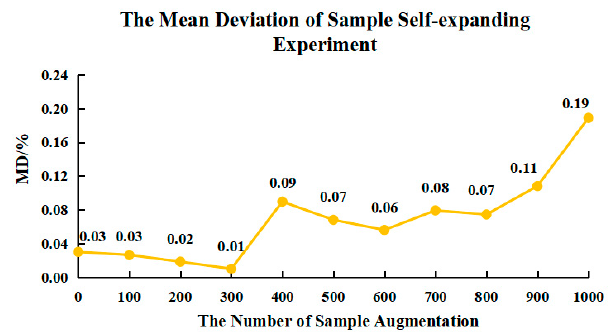
Figure 8. MD of the results for various numbers of self-expanding samples.